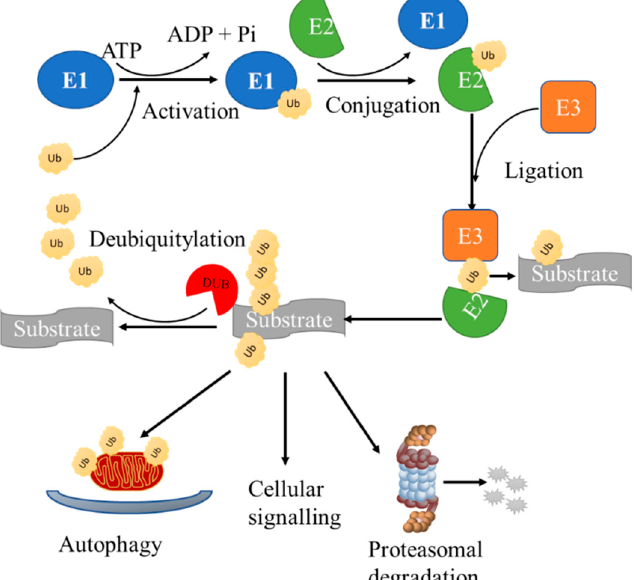
Figure 1. Ubiquitylation pathway. Free ubiquitin (Ub) binds to substates via the sequential steps of three enzymes: E1 (ubiquitin-activating enzyme), E2 (ubiquitin-conjugated enzyme) and E3 (ubiquitin-ligating enzyme). After the binding of Ub to different substrates, such as proteins or organelles (e.g., mitochondria), they undergo degradation via the proteasomal or autophagy pathway, depending on the type of the Ub modification. Ub can be removed by deubiquitinating enzymes (DUBs) in the cells, which cleave the peptide bond between Ub and its substrates.